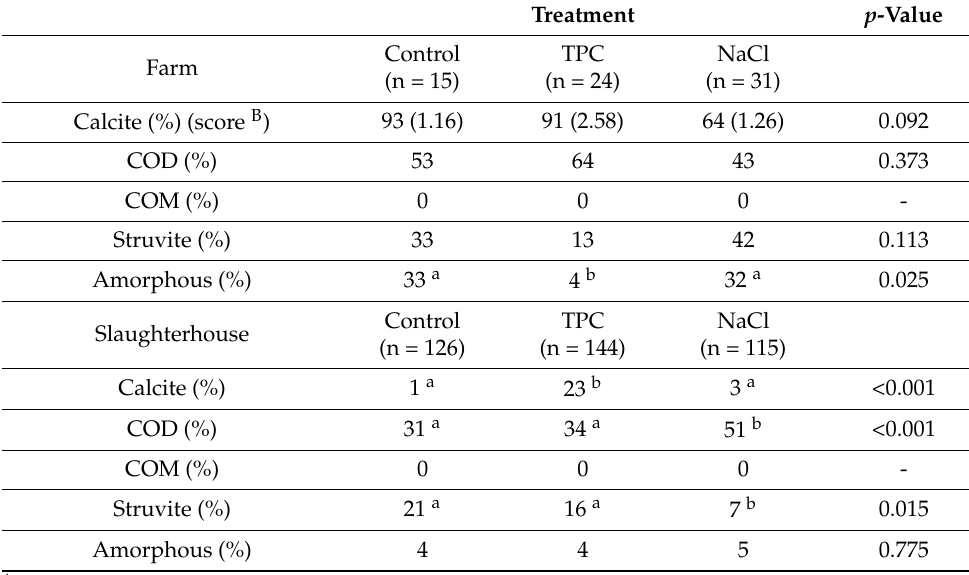
Table 6. Microscopic findings A of the urine samples taken at the farm and in the slaughterhouse from fattening pigs receiving three dietary treatments: the control group (control) received the normal feed used on the farm, the tripotassium citrate (TPC) and the sodium chloride (NaCl) groups received the normal feed supplemented with 0.25% TPC and 0.20% NaCl,